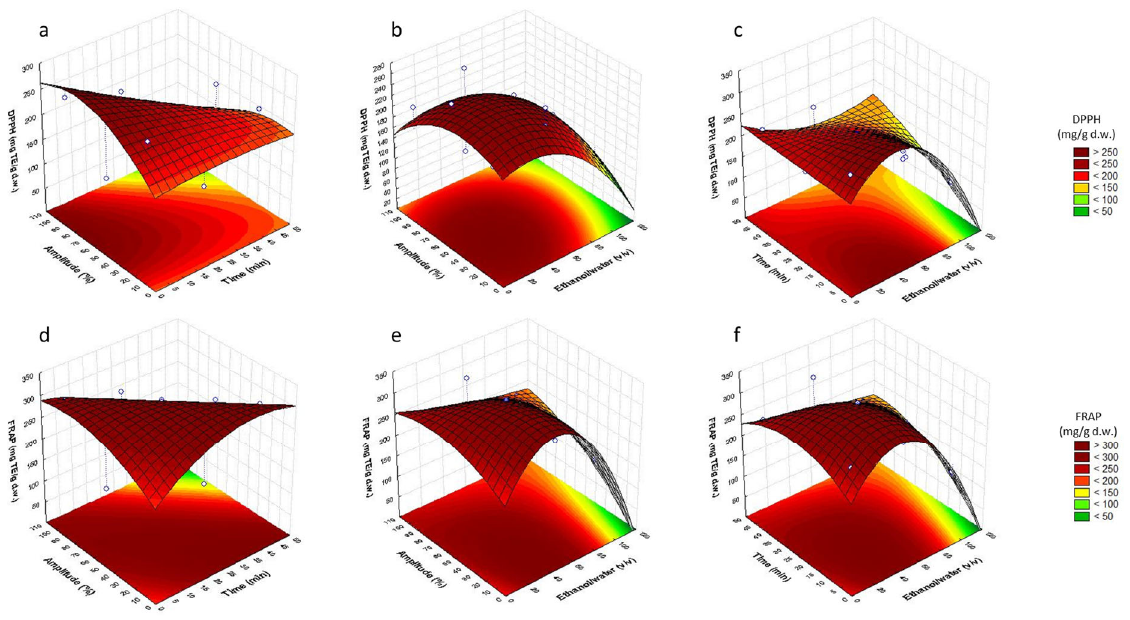
Figure 2. Response surface plots showing combined effects of process variables for DPPH and FRAP (mg TE/g d.w.): amplitude—time (min) ( a , d ), amplitude—% EtOH ( b , e ) and % EtOH—time (min) ( c , f ).